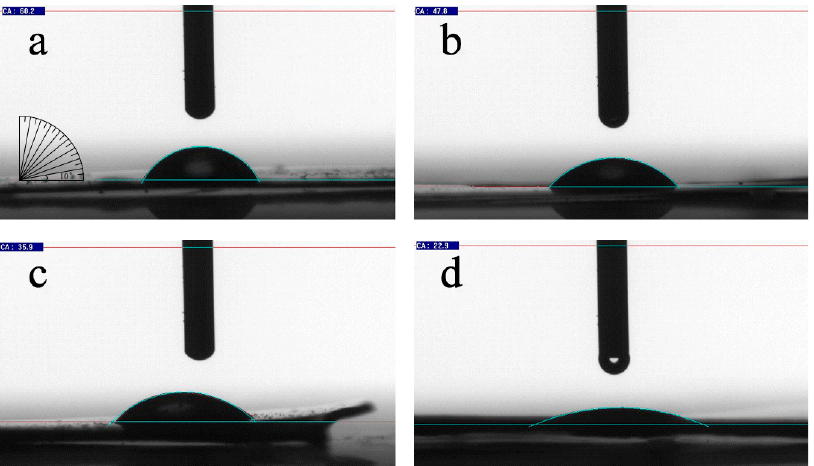
Figure 2. The contact angles of the different aluminum surfaces: ( a ) Sample 1, θ = 60.2°; ( b ) Sample 2, θ = 47.8°; ( c ) Sample 3, θ = 35.9°; and ( d ) Sample 4, θ = 22.9°.